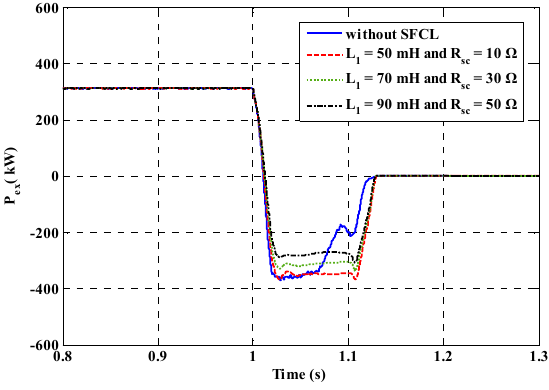
Figure 11. Active power of the micro ‐ grid at the PCC under the external fault.